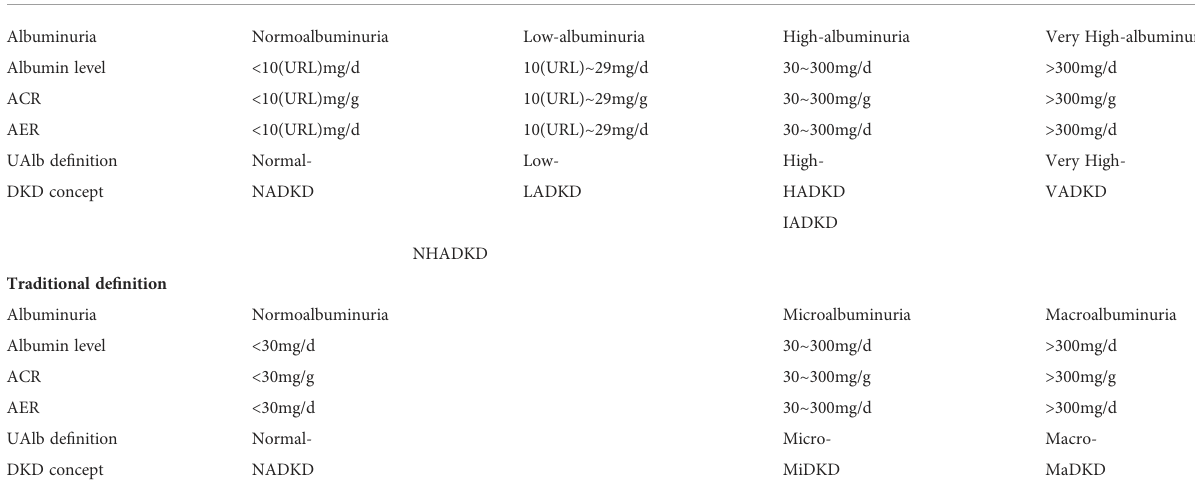
TABLE 2 Comparison of new and old concepts of albuminuria diabetic kidney